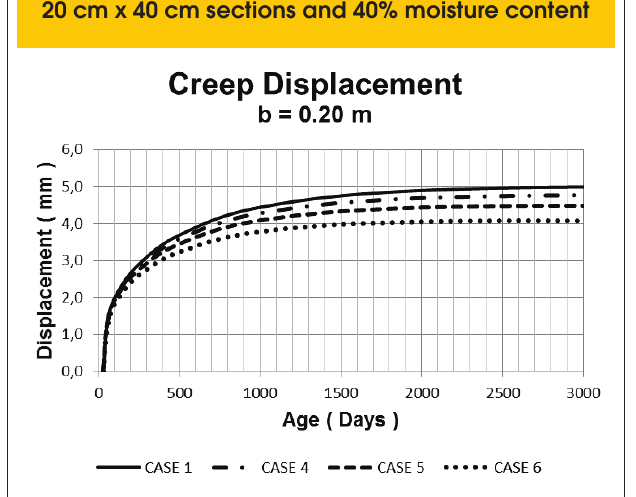
Figure 10 – Creep displacement curves for 20 cm x 40 cm sections and 40% moisture